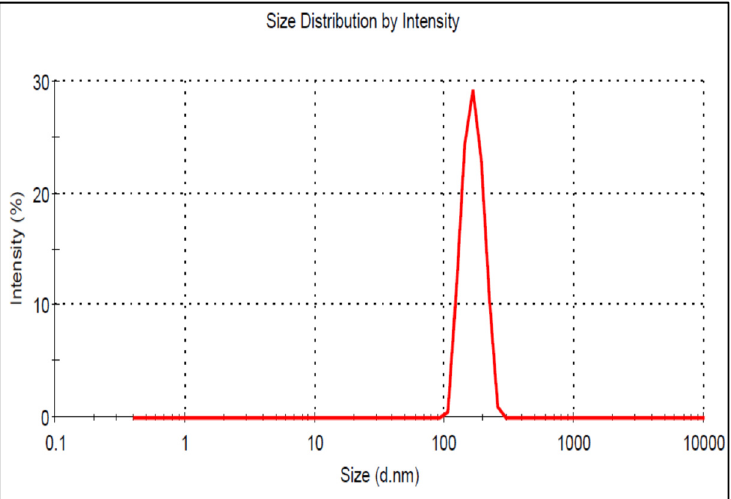
Figure 5. Particle size image of BF-NLCopt.